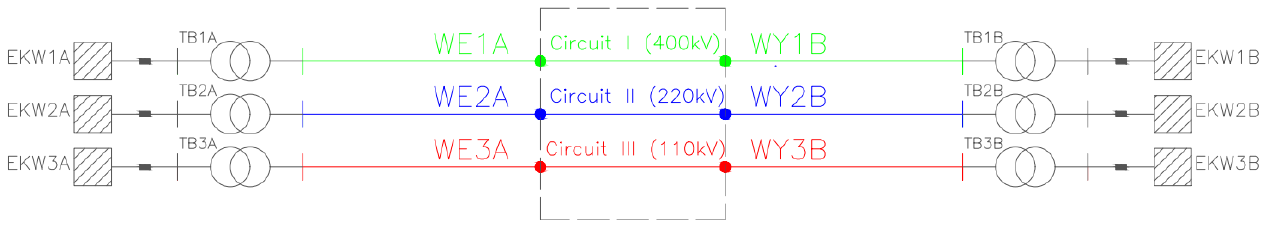
Figure 3. Network system model with a Three-circuit Transmission Line designed in ATP-EMTP program.